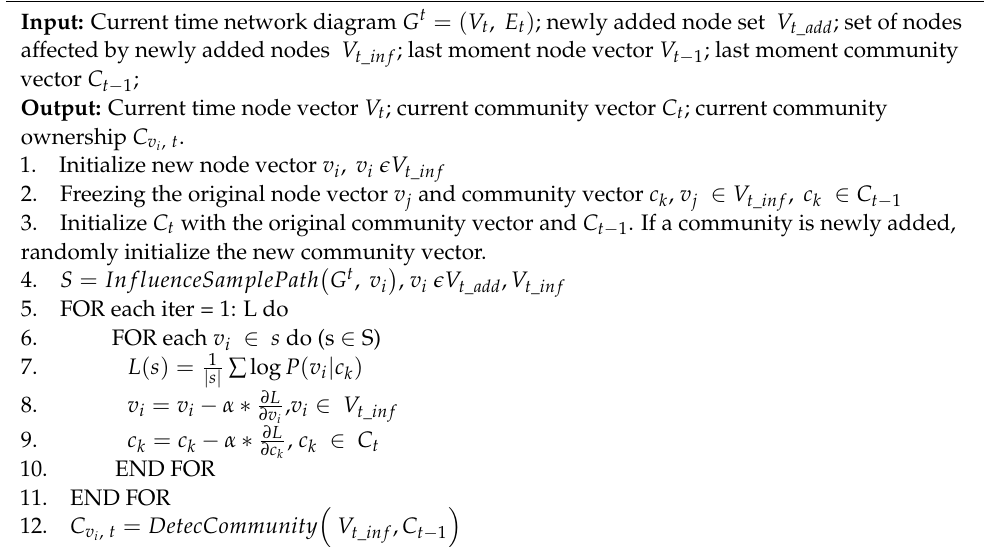
Algorithm 3 Dynamic community detection when new nodes are added and | C |